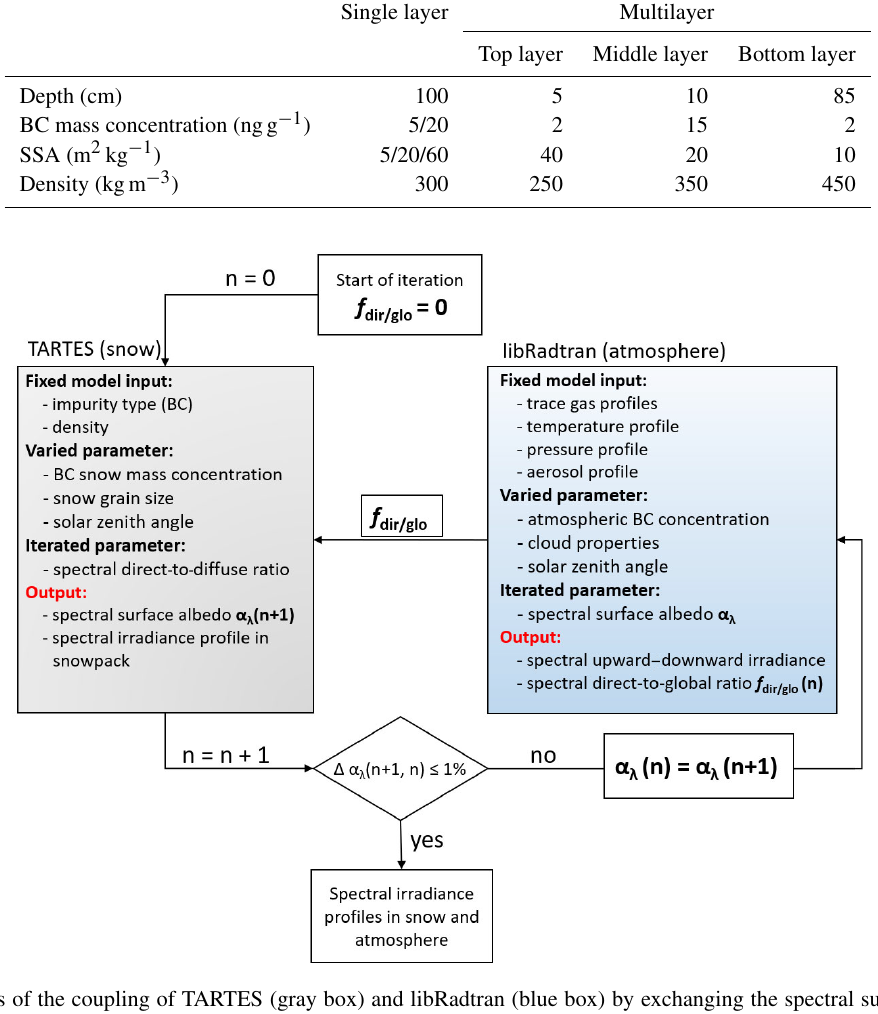
Figure 2. Schematics of the coupling of TARTES (gray box) and libRadtran (blue box) by exchanging the spectral surface albedo and the direct-to-global ratio. The list of varied parameters addresses the variables which were changed between the different realizations. Only the iterated parameters f dir / glo and α λ were adjusted within an individual iteration